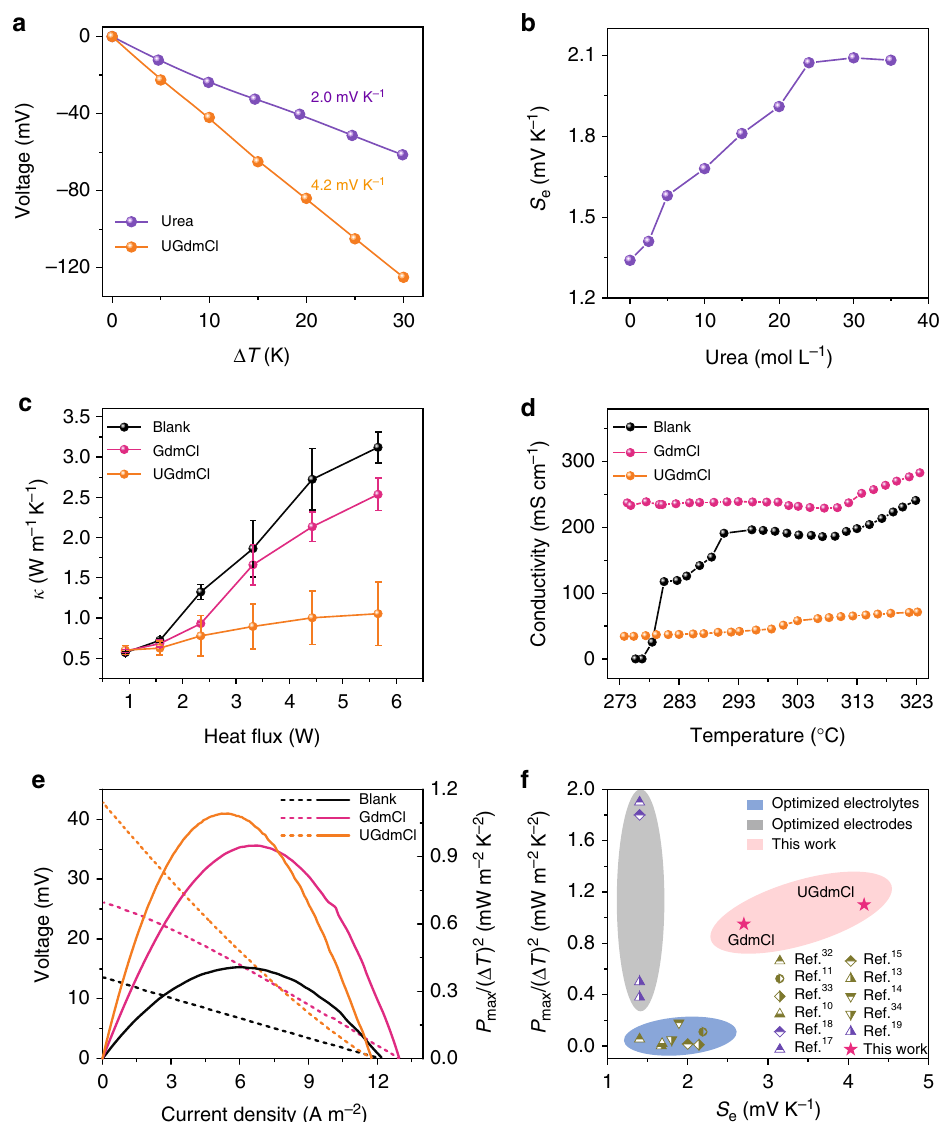
Fig. 3 Performance of the optimized TGC systems. a The Seebeck effects of the [Fe(CN) 6 ] 3 − /[Fe(CN) 6 ] 4 − electrolyte containing only urea or urea/GdmCl composite (UGdmCl). The concentrations of urea and GdmCl were 24 and 2.6 M, respectively. b Dependence of the Seebeck coef fi cient on the concentration of urea. c Dependence of the thermal conductivity on the input heat fl ux. The error bar is received from the temperature gradient at three different positions of the cross-section of cells according to the regarding method in Supplementary Note 4. d Dependence of the electrical conductivity on the temperature. e Voltage output and the corresponding power output. The temperature difference was 10 K ( “ cold ” side at 293 K, “ hot ” side at 303 K). f Comparison of the P max /( Δ T ) 2 and S e values with those reported in the